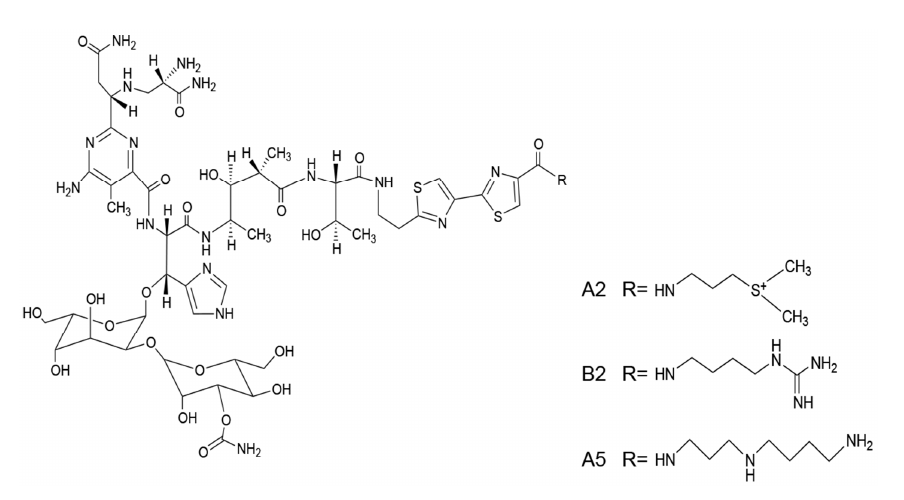
Figure 1. The structures of bleomycin (BLM) A2, B2 and A5.